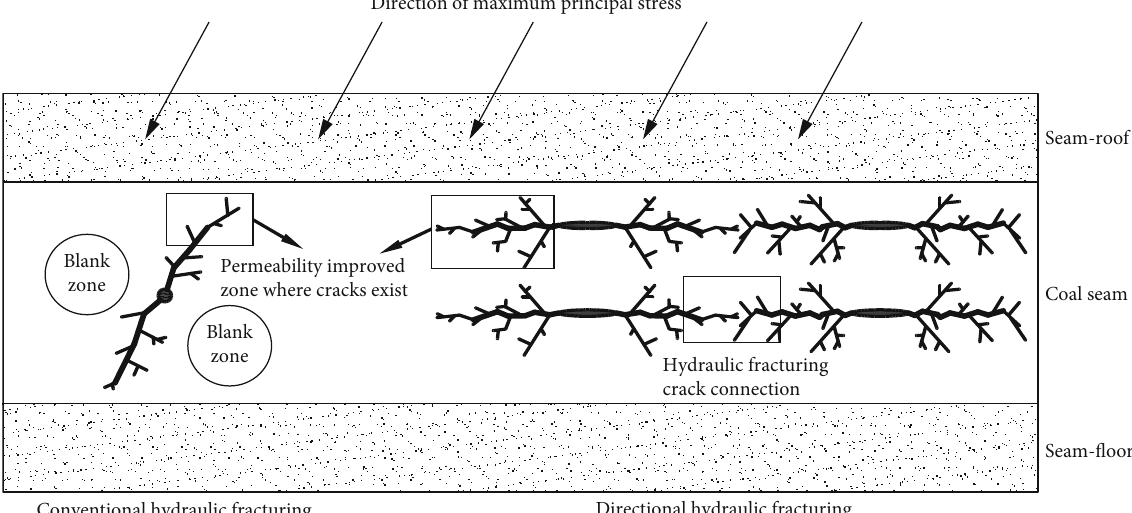
Figure 1: Schematic diagram of directional hydraulic fracturing (DHF) based on hydraulic slotting and a nonuniform pore pressure gradient.